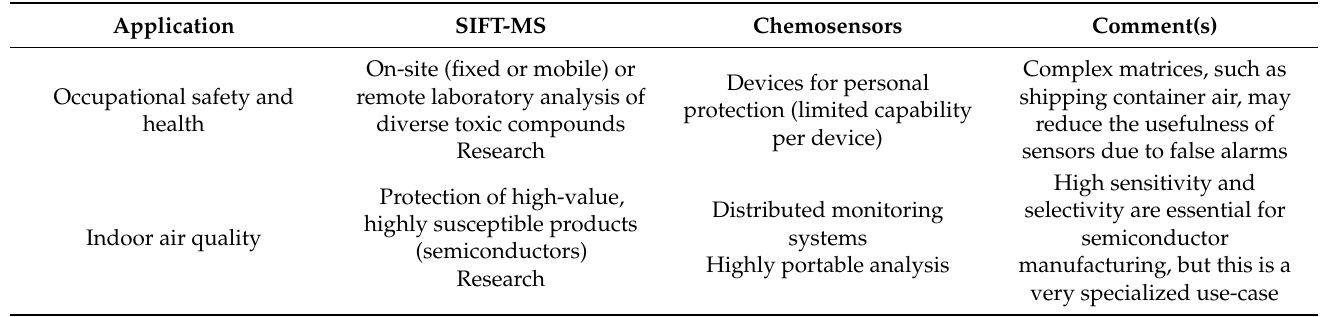
Table 5. The complementary nature of SIFT-MS and chemosensor detection of hazardous volatiles in the application areas discussed in Section 4.